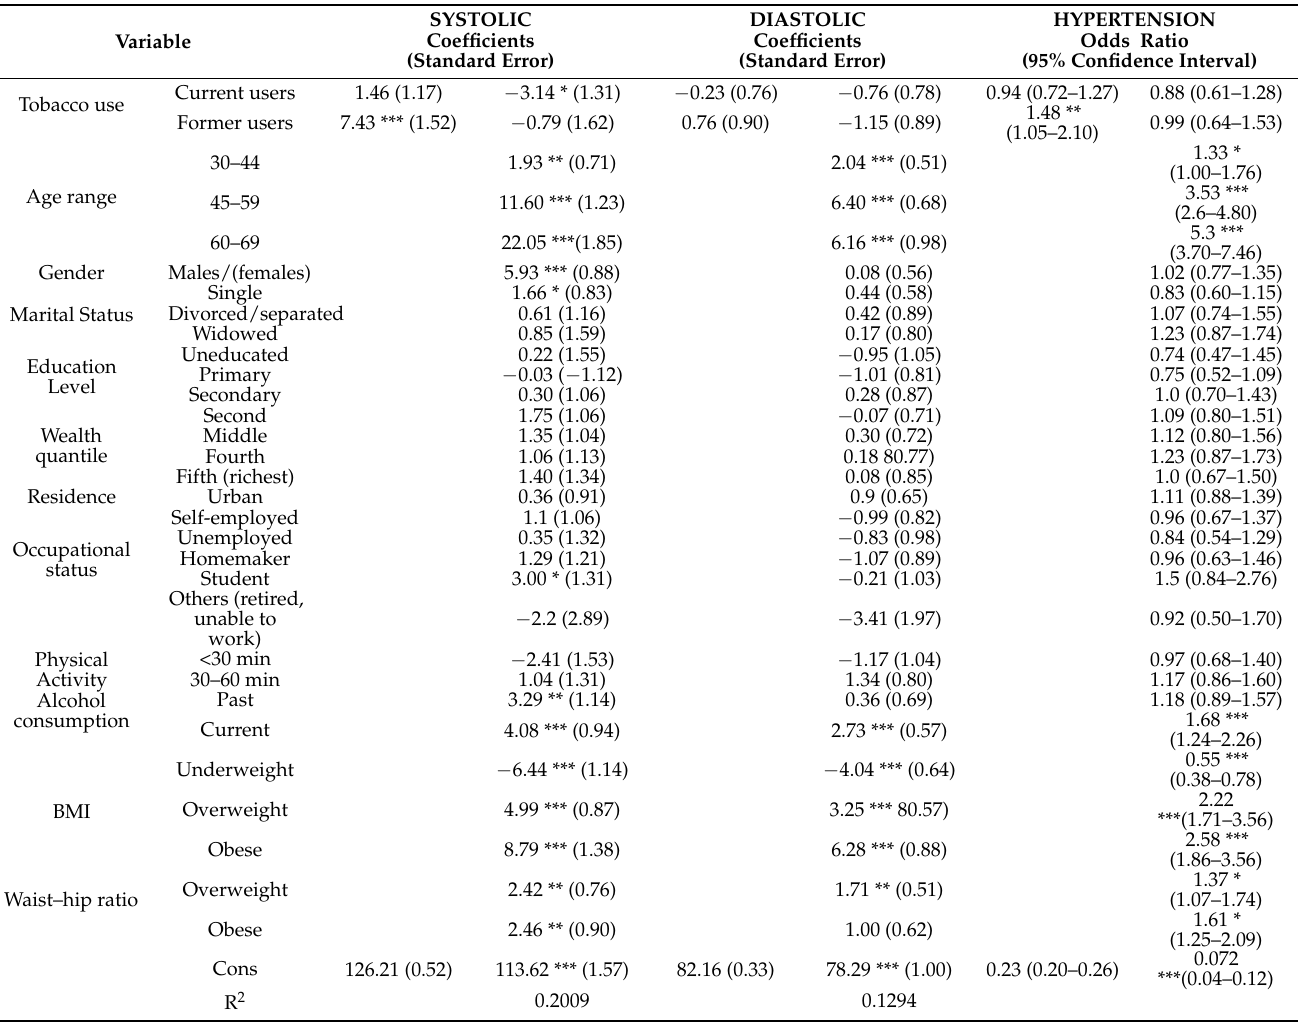
Table 5. Multiple linear and logistic regressions